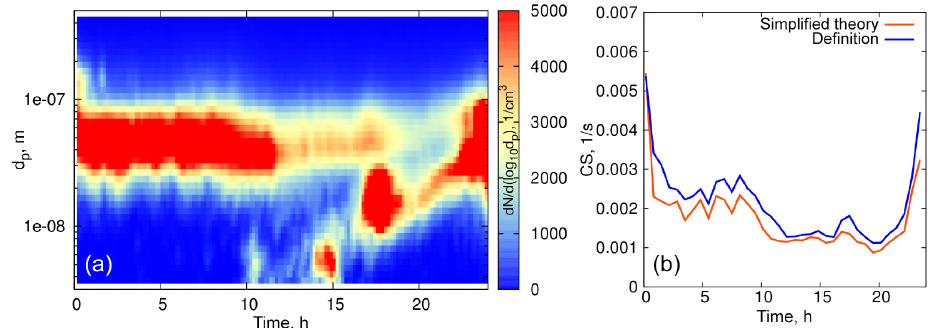
Figure 4. (a) Particle number distribution on 27 March 2014, Hyytiälä. (b) Time evolution of the condensation sink below 500nm. Blue curve: calculated from the definition, orange: calculated using formula (16).